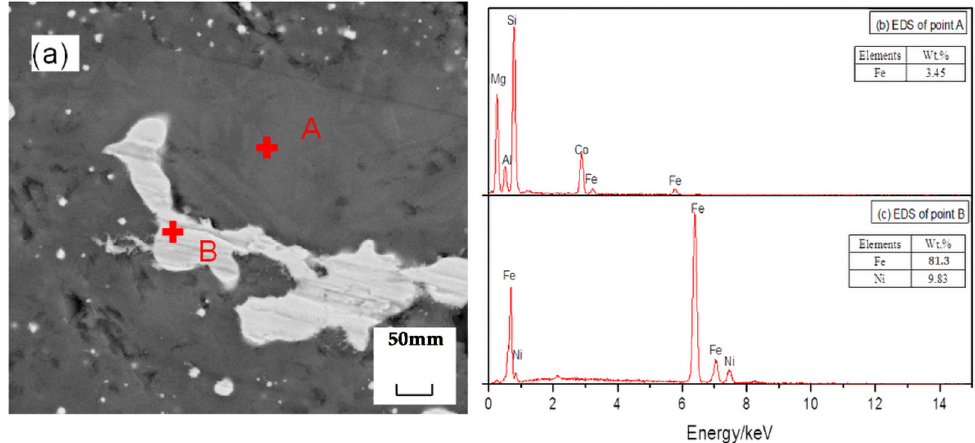
Figure 11. SEM/EDS analysis of reduction samples under the action of ferronickel concentrate; ( a ) scanning electron microscope image, ( b ) EDS spectrum of spot A in image ( a ), ( c ) EDS spectrum of spot B in image ( a ).